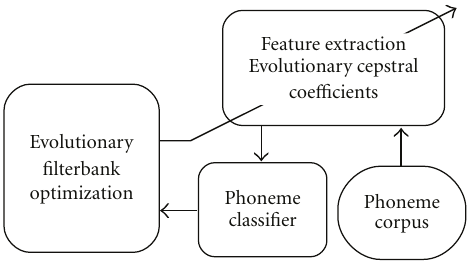
Figure 1: General scheme of the proposed